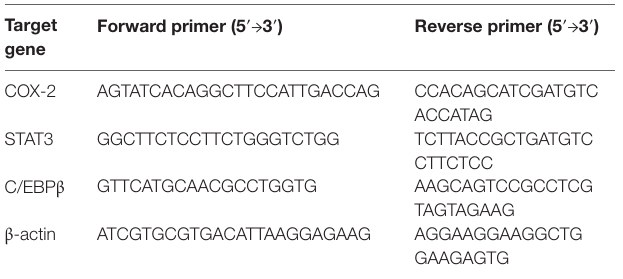
TABLE 1 | Primers used for